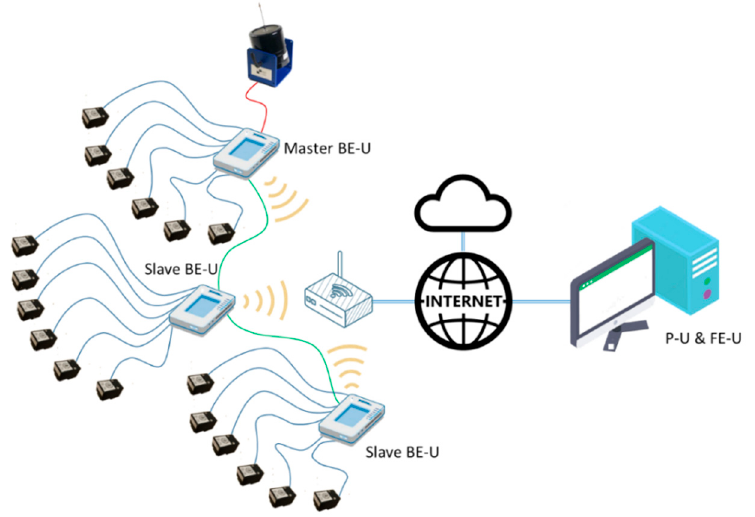
Figure 4. Distributed system configuration.